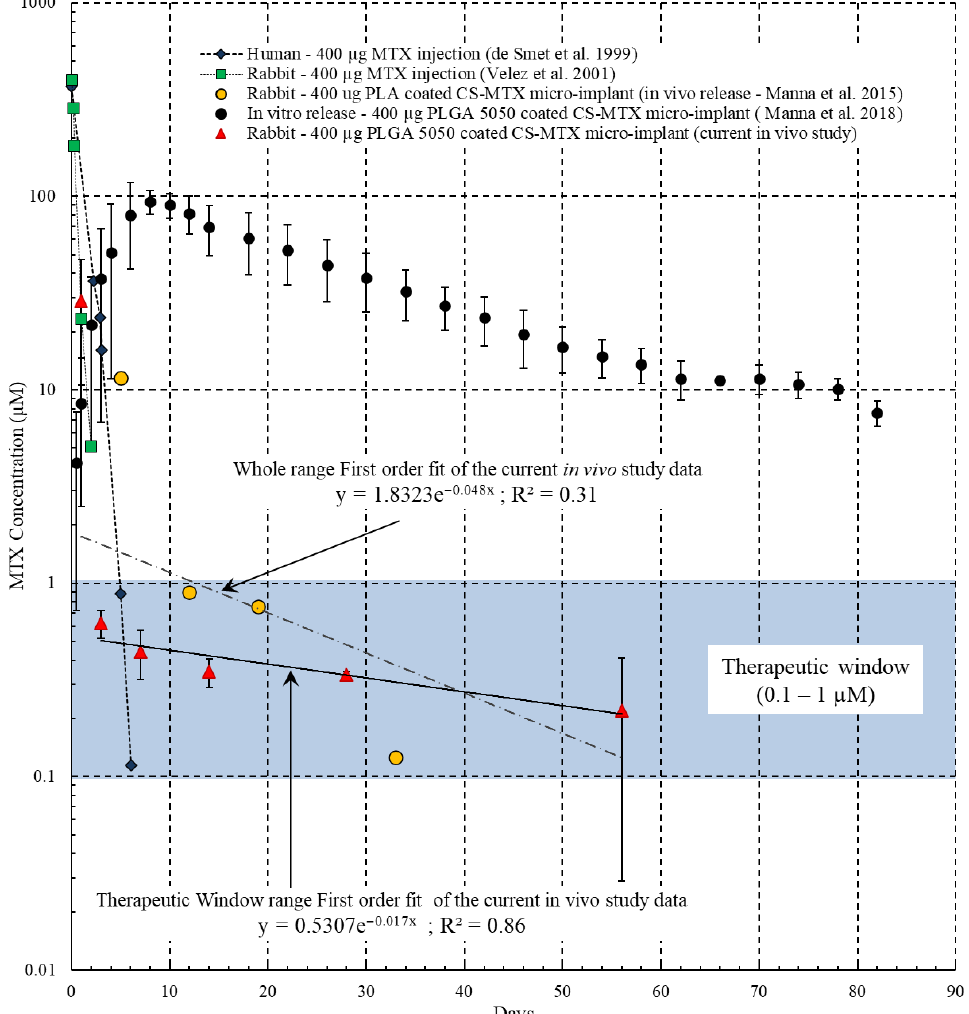
Pharmaceutics 2021 , 13 , x FOR PEER REVIEW